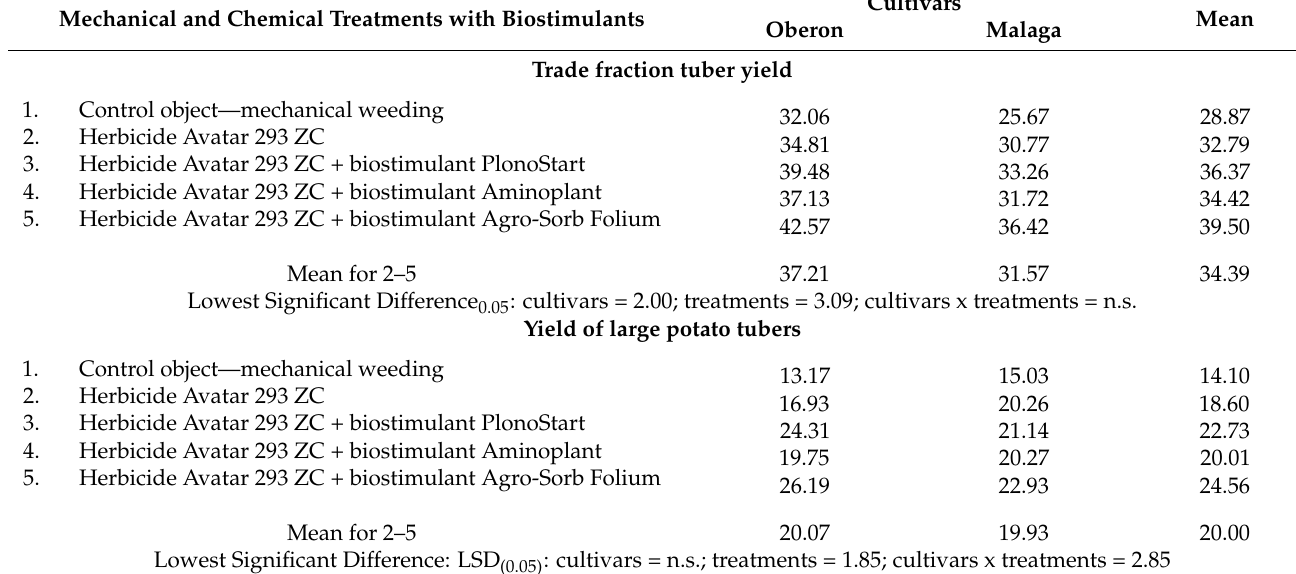
Table 5. Yields of potato tubers in t · ha − 1 (mean for the years 2018–2020). Mechanical and Chemical Treatments with